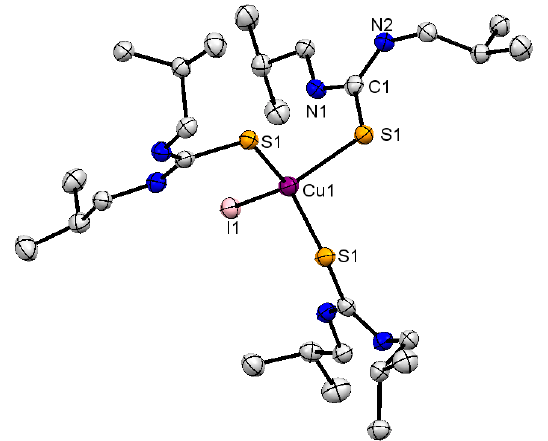
Figure 3. Molecular structure of compound 2 with partial numbering scheme. Thermal ellipsoid drawn at 50% probability level, hydrogens are omitted for simplicity, summarized bond lengths (Å) and angles (°) are given in Table 2.